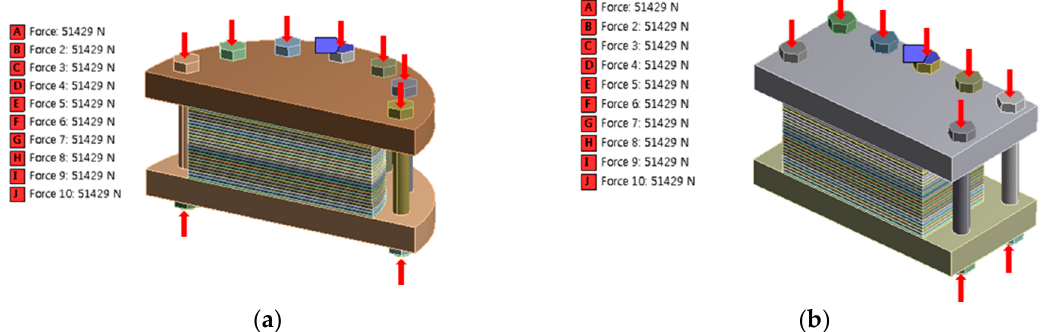
Figure 2. Clamping pressure boundary conditions on ( a ) the circular stack and ( b ) the square